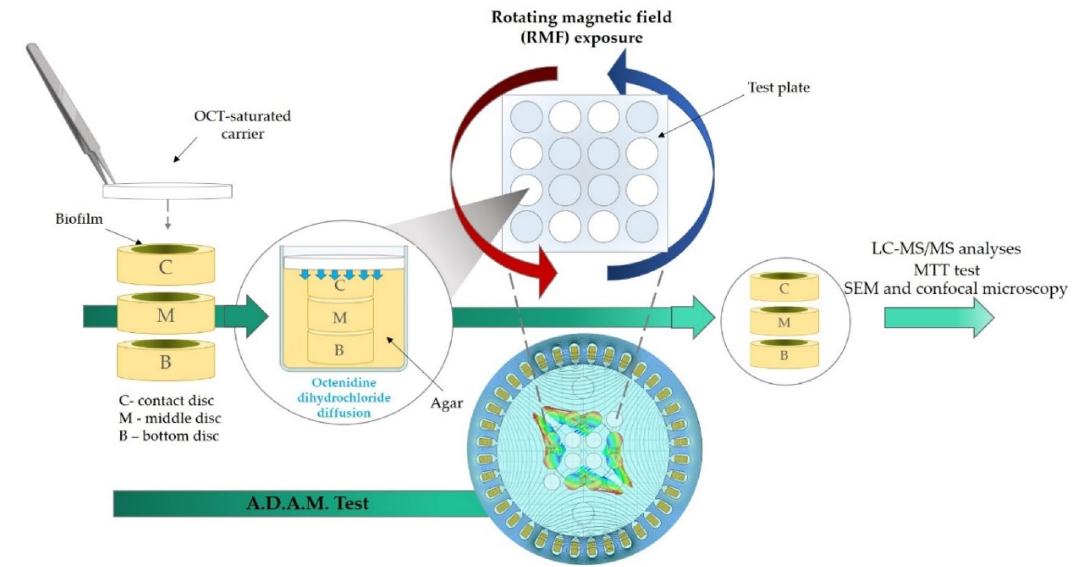
Figure 2. The graphical presentation of the A.D.A.M. test and the arrangement of the test plate during the exposure to rotating magnetic field